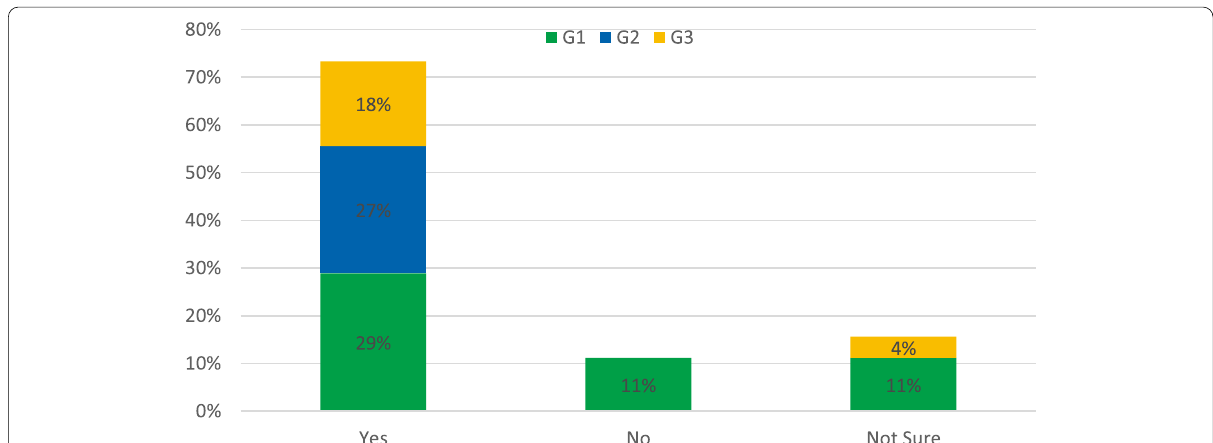
Fig. 10 Response to: Do you believe that public transport data can support our public road network and provide data on road condition and